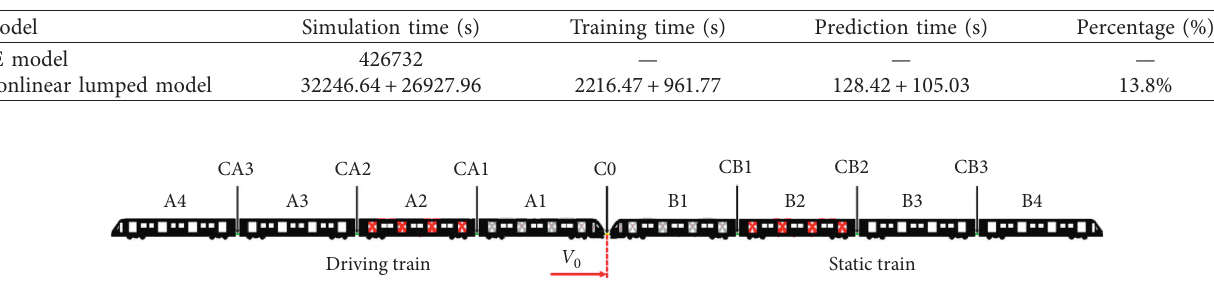
Figure 19: Comparison of crash dynamic characteristics obtained from different modeling. (a) Displacement comparison of CLGAN model and FE model. (b) Velocity comparison of CLGAN model and FE model. (c) Acceleration comparison of CLGAN model and FE model. Table 2: The comparison of the analysis time of different